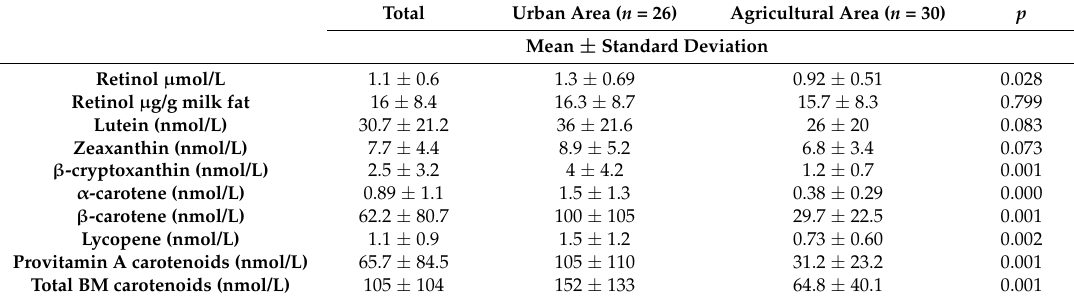
Table 2. Concentration of retinol and carotenoids found in breast milk of participant lactating mothers. Total Urban Area ( n = 26) Agricultural Area ( n = 30) p Mean ± Standard Deviation Retinol µ mol/L